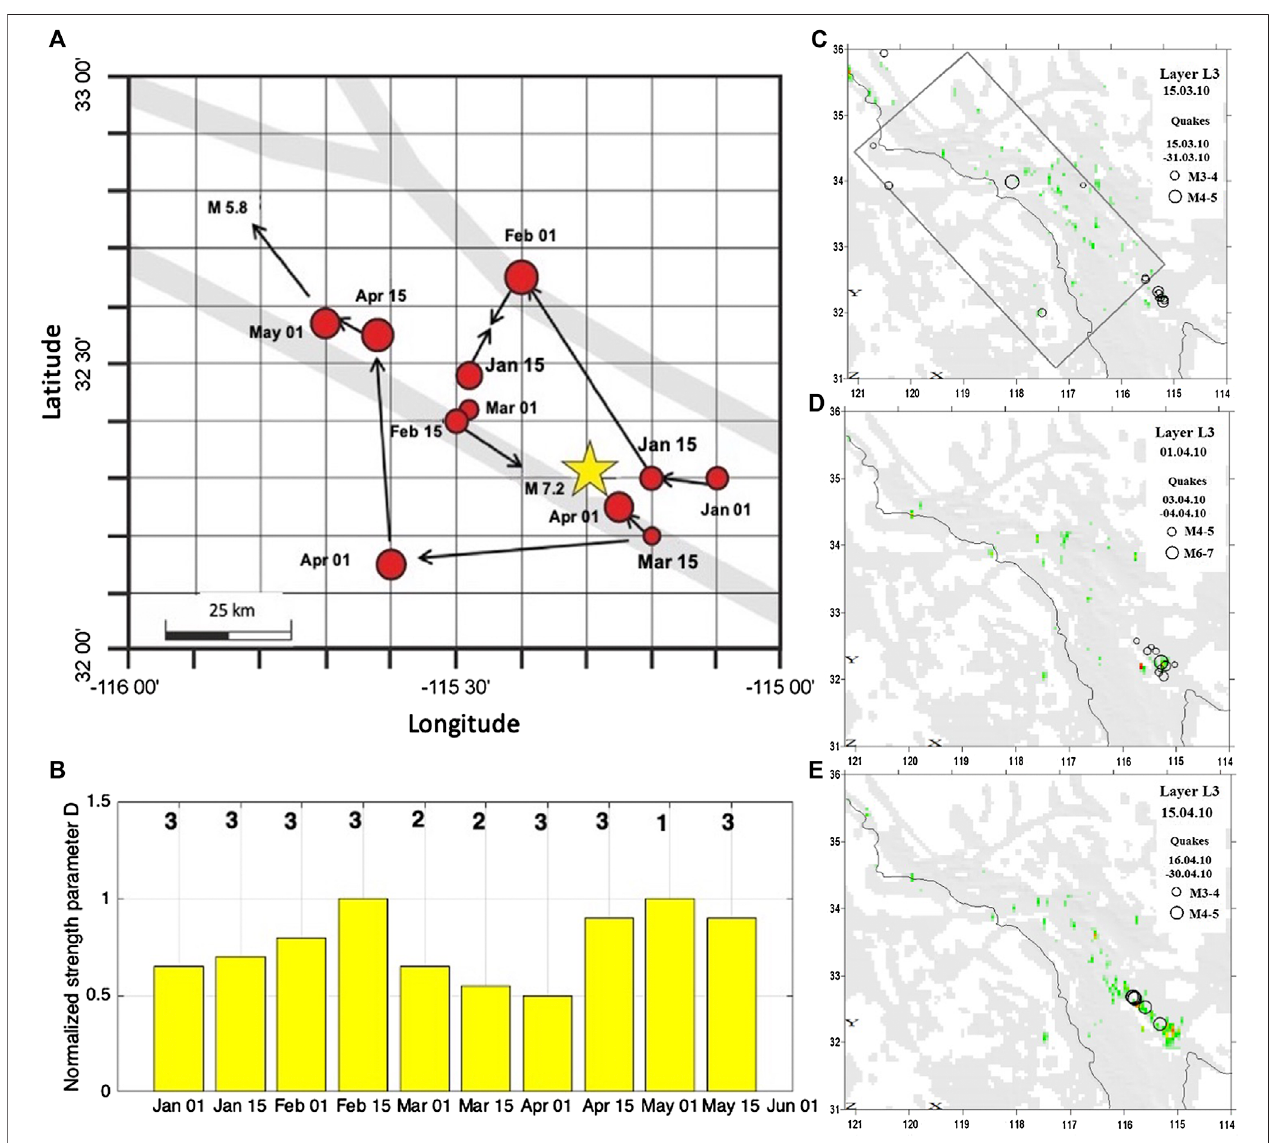
FIGURE 7 | (A) Migration path of the strength parameter D maximum (red circles), as it is approaching the future epicenter of the M 7.2 earthquake (yellow star) duringJanuary – July2010.Gray-coloredregionsindicatezonesofelevatedrockdamage; (B) variationinnormalizedmaximumstrengthparameter D ,calculatedoverthe modeldomain;numbers abovethebars indicatethecorrespondingmodellayer. (C) – (E) Particularstatesofmiddlecrustallayer3intermsof D forMarch15,April1,and April 15, 2010, with black circles showing the epicenters of main shocks, occurring during this period.